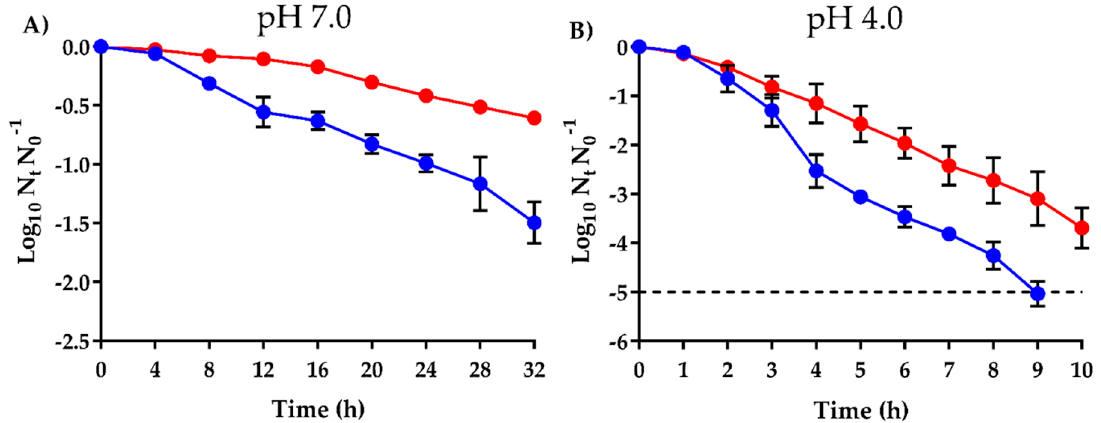
Figure 2. Survival curves of Staphylococcus aureus USA300 ( ● ; SaWT) and evolved strain ( ● ; SaROEO), after 2000 μ L/L orange essential oil (OEO) treatment at pH 7.0 ( A ) and pH 4.0 ( B ) at 37 °C. Data are means ± standard deviations (error bars) obtained from at least 3 independents experiments. Dashed line represents the detection limit ( − 5.0 log 10 ).